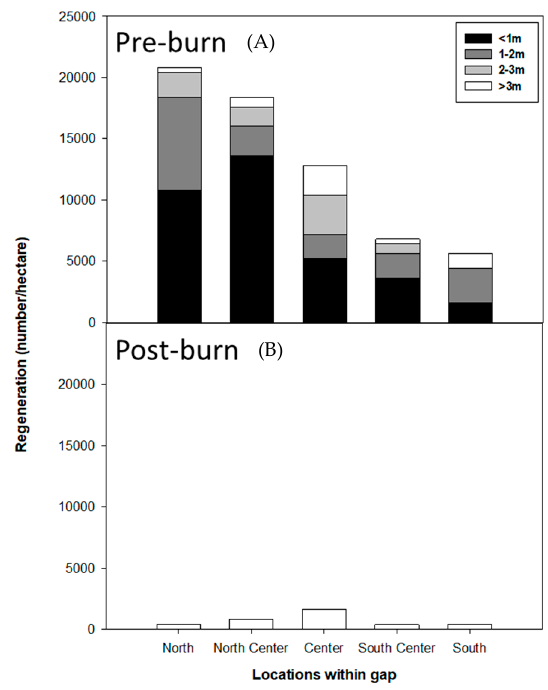
Figure 5. Pre-burn ( A ) and 10-month post-burn ( B ) regeneration size and number distribution at different gap positions in a group selection harvest in slash pine. Only regeneration >3 m survived 10 months after the burn.